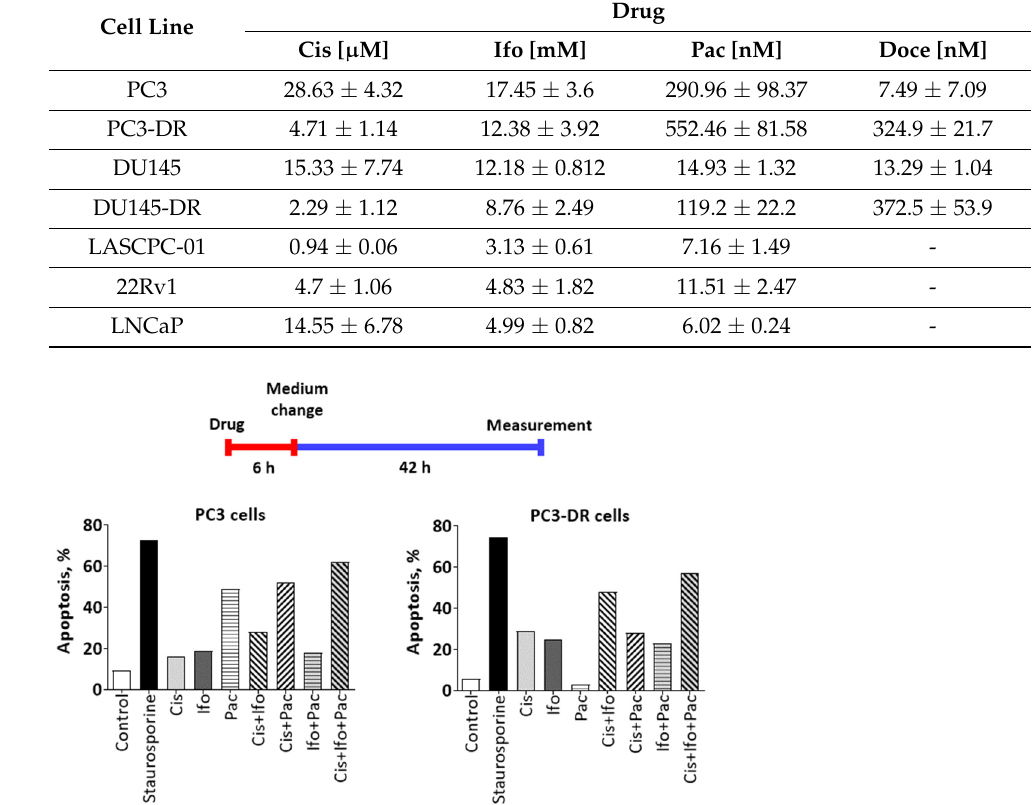
Table 3. Cytotoxic activity of the drugs in vitro. IC 50 of cisplatin (Cis), ifosfamide (Ifo), and paclitaxel (Pac) were evaluated in various prostate cancer cell lines following 48 h of treatment using an MTT assay. The data are represented as mean ± standard deviation.